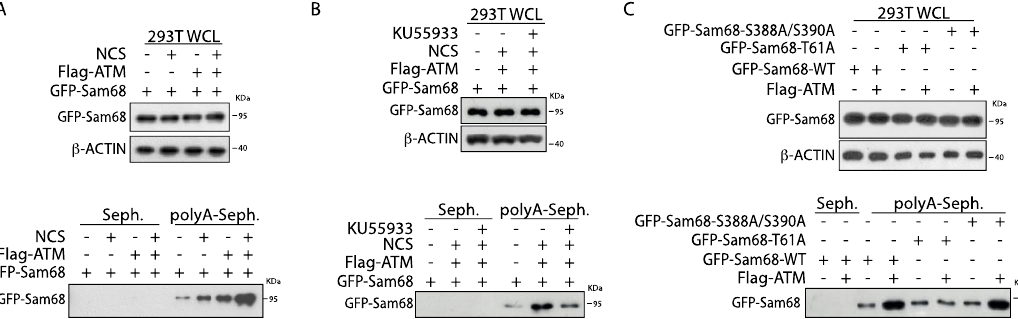
Figure 5. ATMmodulates Sam68 RNA binding affinity upon DDR induction. ( A – C ) Western blot analysis of pull-down assays performed using synthetic homopolymeric RNA. HEK293T cells were transiently transfected with indicated GFP-Sam68 plasmids and/or in addition to FLAG-ATM ( A – C ). After 24 h, cells have been treated, or not, with neocarzinostatin (NCS, 500 ng/mL) for 1 h ( A ) in presence, or not, of KU55933 (1 h) ( B ). Cell extracts (WCL) were incubated with either polyA- Sepharose (polyA) and streptavidine – Sepharose (Seph.) beads. Streptavidine – Sepharose beads have been used as negative control.